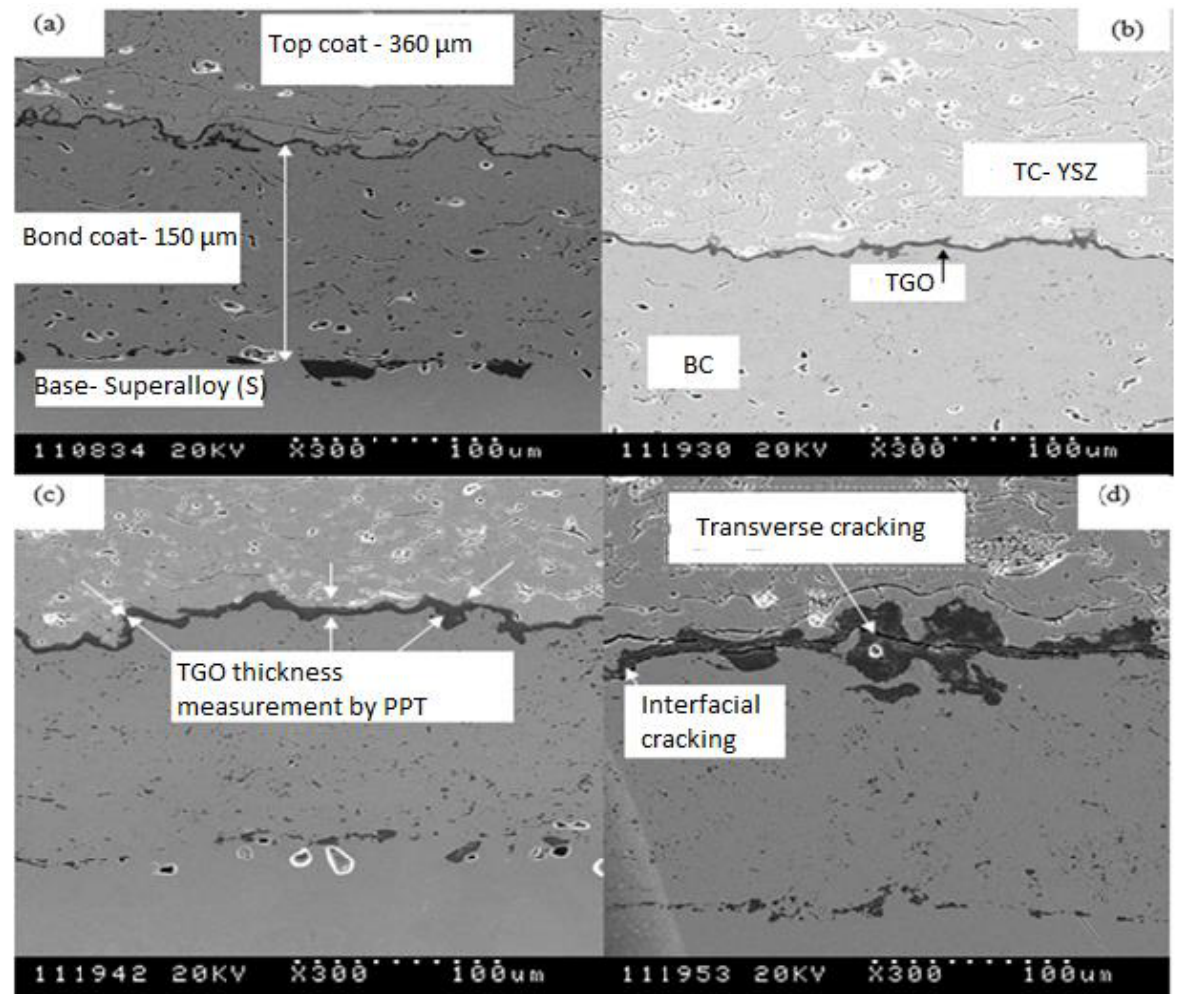
Figure 2. ( a – d ). SEM image of conventional 2-layer APS TBC displaying the structural layer arrangements of the substrate (S), BC, TC and TGO growth profile at the BC–TC interface after thermal cycling; ( a ) 10 cycles ( b ) 100 cycles ( c ) 430 cycles and ( d ) at failure around 1425 cycles [32]. Additionally, the thickness of different layers, TGO measurements and cracking around TGO are also evident.